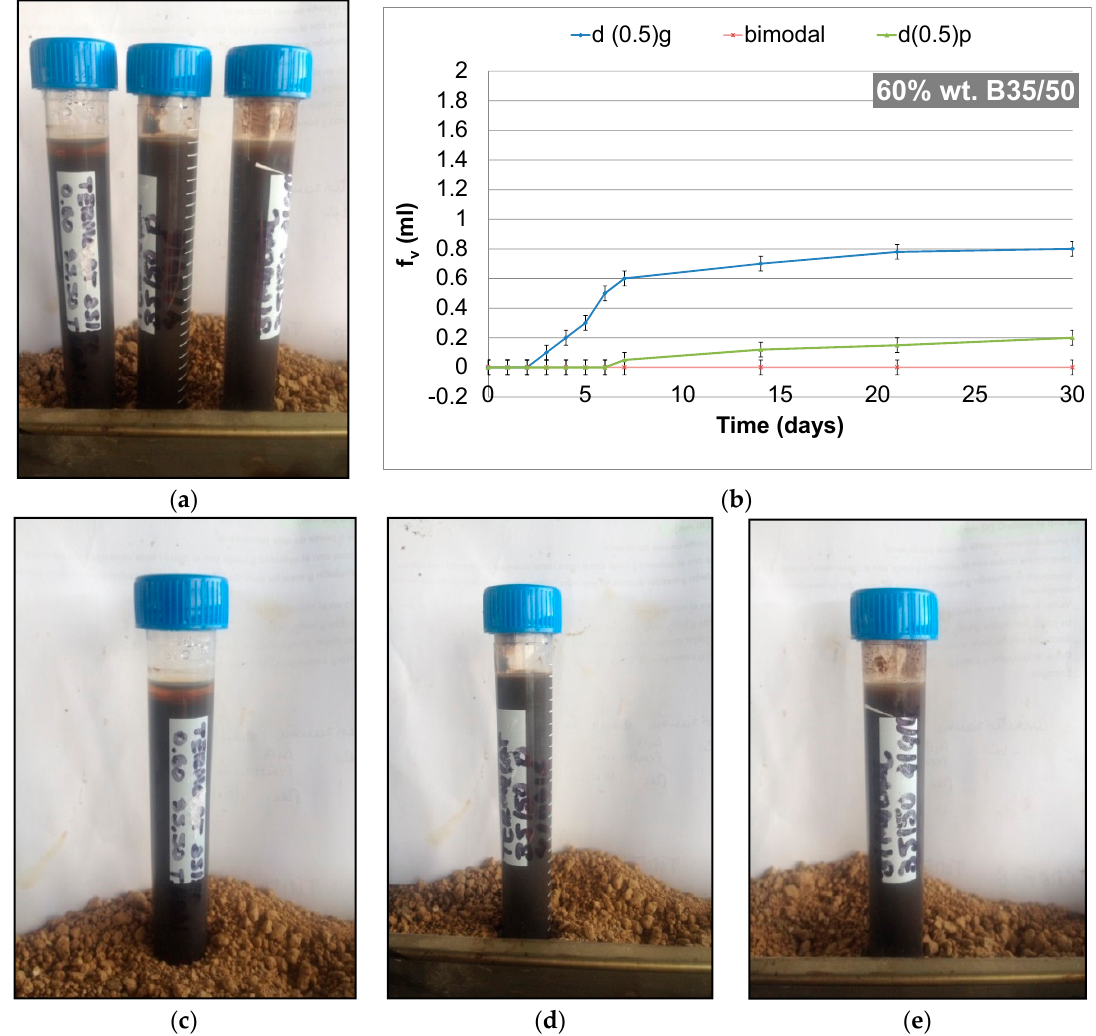
Figure 8. Emulsions of 60 wt. % B35/50: ( a ) global vision; ( b ) sedimentation curve; ( c ) monomodal d(0.5) l ; ( d ) monomodal d(0.5) s ; ( e ) bimodal emulsion. Table 3. Viscosity measurement for the different prepared samples.